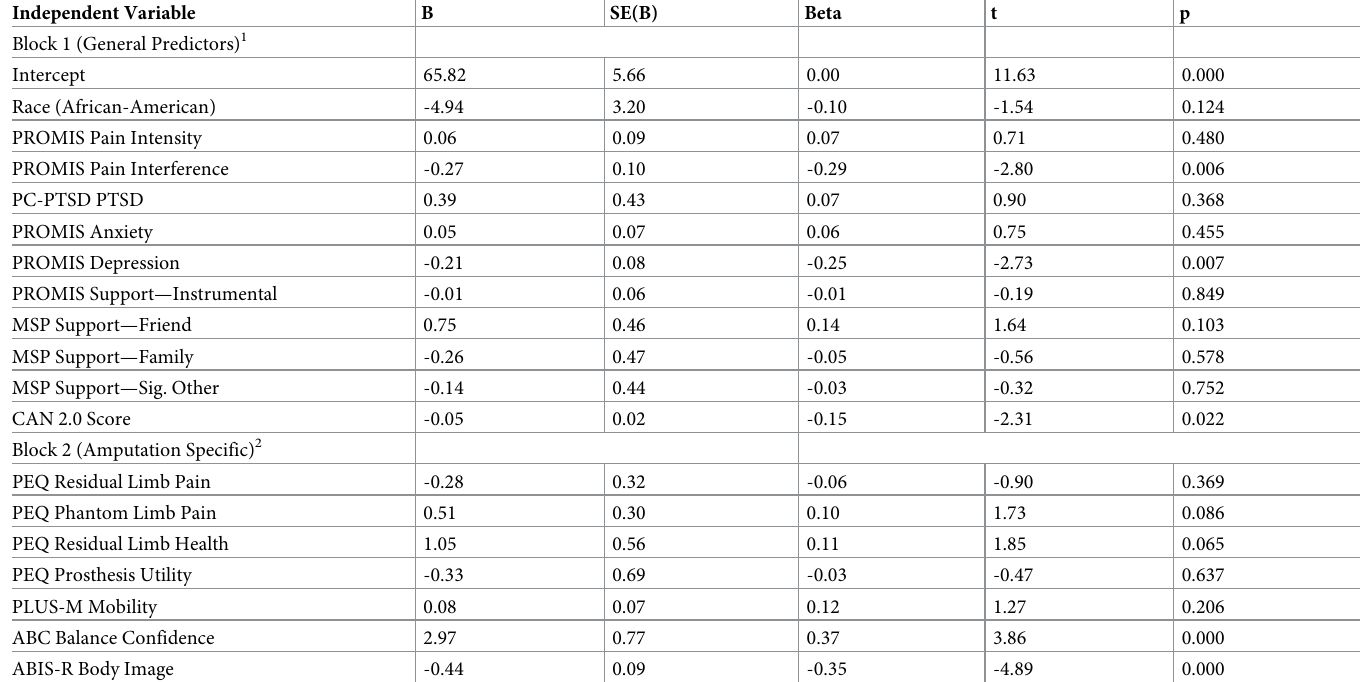
Table 7. Regression of PROMIS ability to participate on general and specific